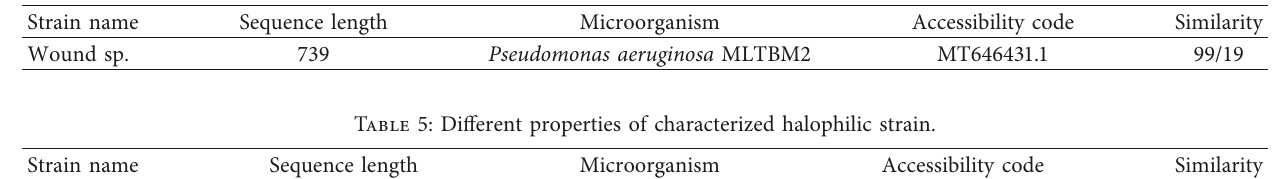
Table 4: Different properties of wound